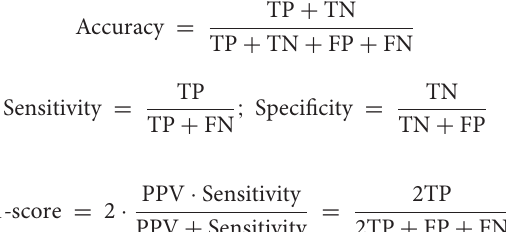
Each ensemble algorithm had a different weight